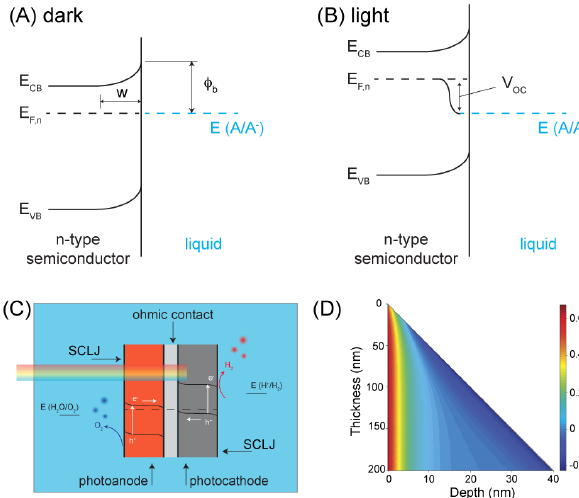
Figure 3: Photo-assisted water splitting: (A) Band energetics of a semiconductor/liquid junction (SCLJ) in the dark, and (B) under illumination. (C) Schematics of PEC water splitting using a dual absorber tandem cell. (D) Predicted internal quantum eflciency P(x) distribution as a function of film thickness and depth for α - Fe 2 O 3 photoanodes. Figure (D) adapted with permission from refer- ence [80]. Copyright (2012) Nature Publishing